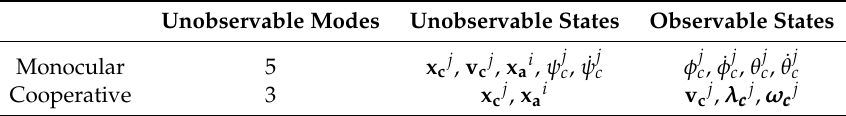
Table 1. Results of the non-linear observability